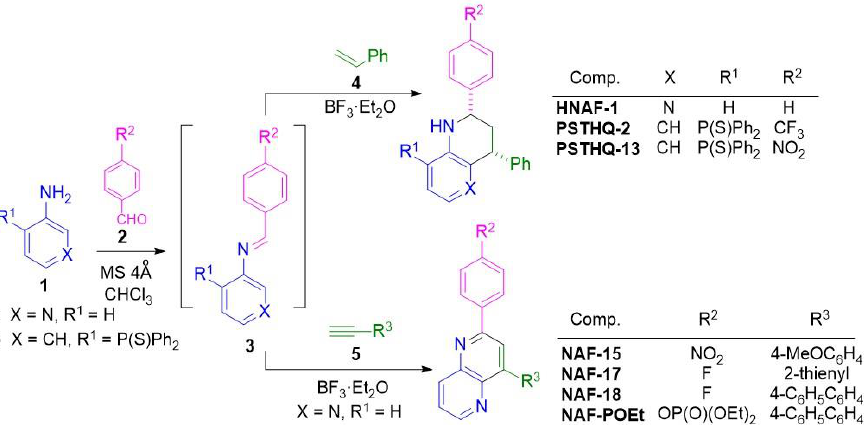
Figure A1. Povarov reaction for the syntheses of HNAF-1, PSTHQ-2, PSTHQ-13, NAF-15, NAF-17, NAF-18, and NAF-POEt.